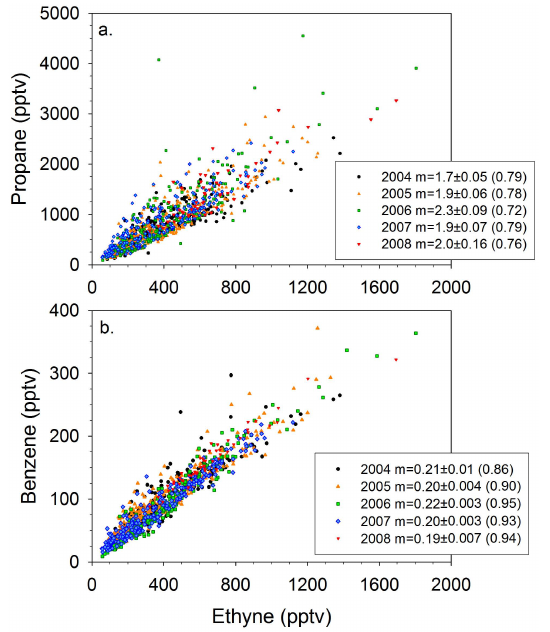
Fig. 9. Correlation ( m =slope ± standard error ( r 2 )) of ethyne with (a) propane and (b) benzene for each year.